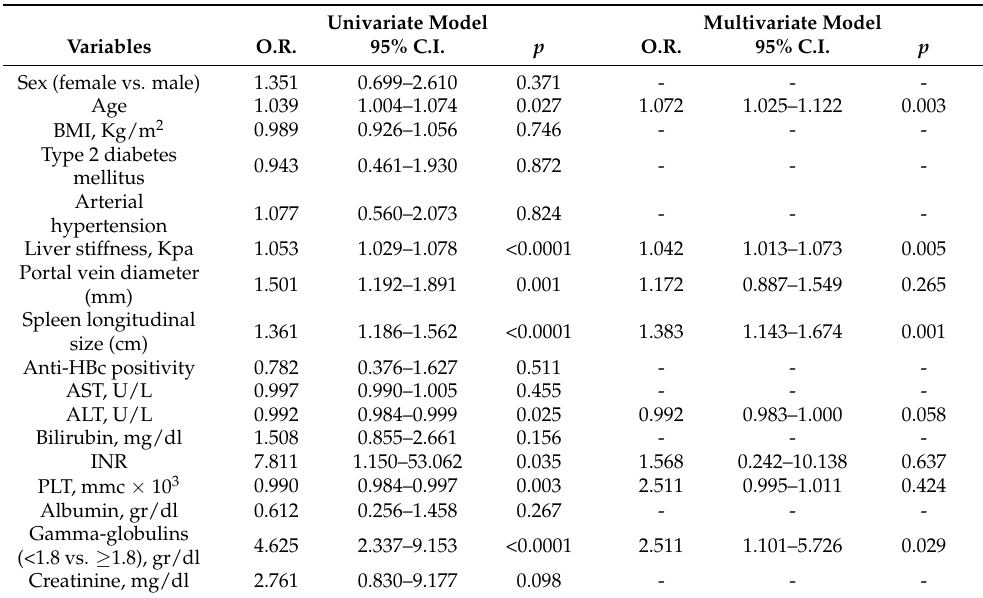
Table 3. Univariate and multivariate logistic regression analyses of different predictors variables of hepatic decompensation.